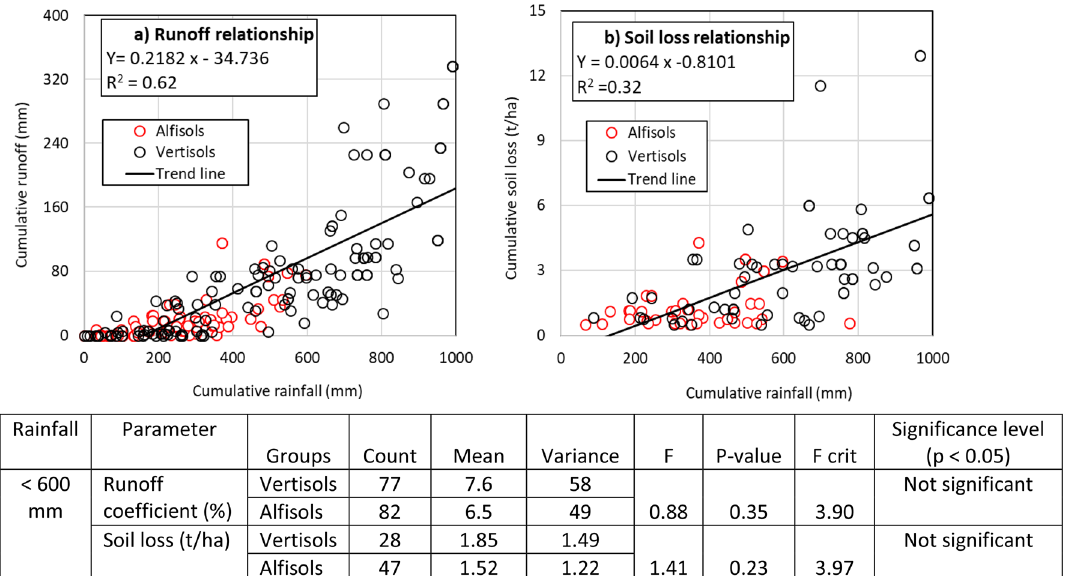
Figure 7. Relationship between cumulative rainfall and ( a ) cumulative runoff and ( b ) cumulative soil loss. The data is from 23 runoff and soil loss gauging stations in different watersheds. The red and black circles indicate responses in Alfisols and Vertisols, respectively.